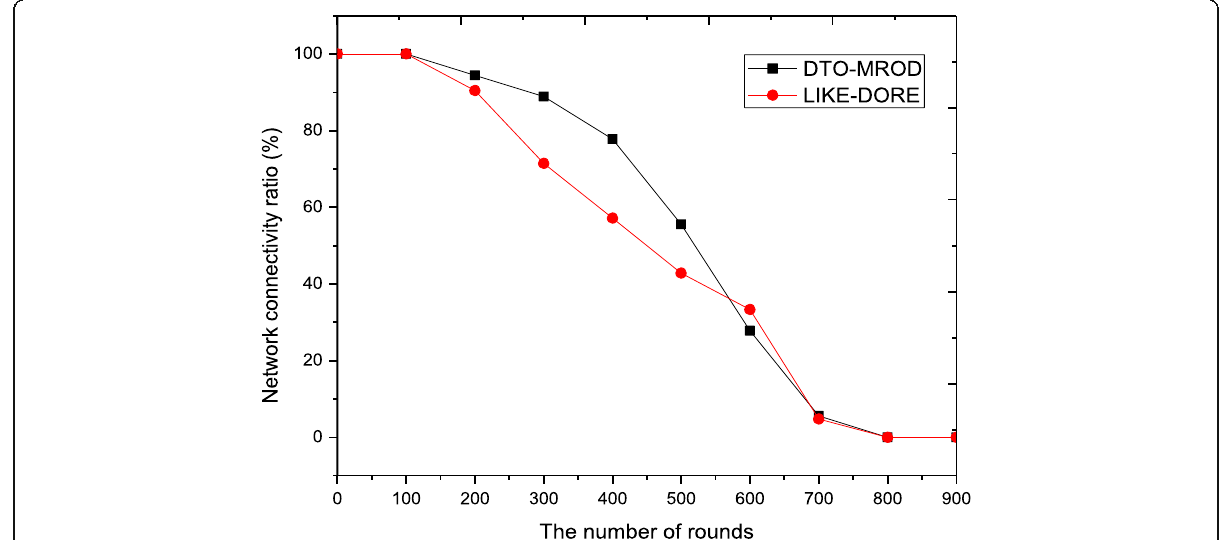
Fig. 9 Network connectivity ratio for the two schemes under the different numbers of